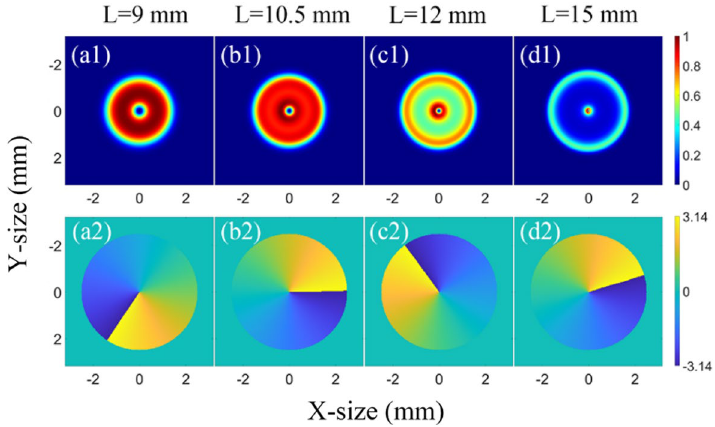
Figure 9. Intensity distributions (a1-d1) and phase distributions (a2-d2) of amplified beams ( l = 1 ) at different crystal lengths in collinear